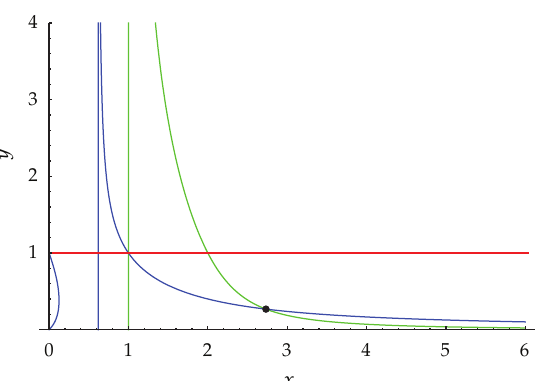
Figure 1: The blue curve is the graph of the equation ϕ 1 (cid:2) x,y (cid:3) (cid:4) 0 with the vertical asymptotic line x (cid:4) √ (cid:2) 5 − 1 (cid:3) / 2 and the green curve is the graph of ϕ 2 (cid:2) x,y (cid:3) (cid:4) 0 with the vertical asymptotic line x (cid:4) 1.